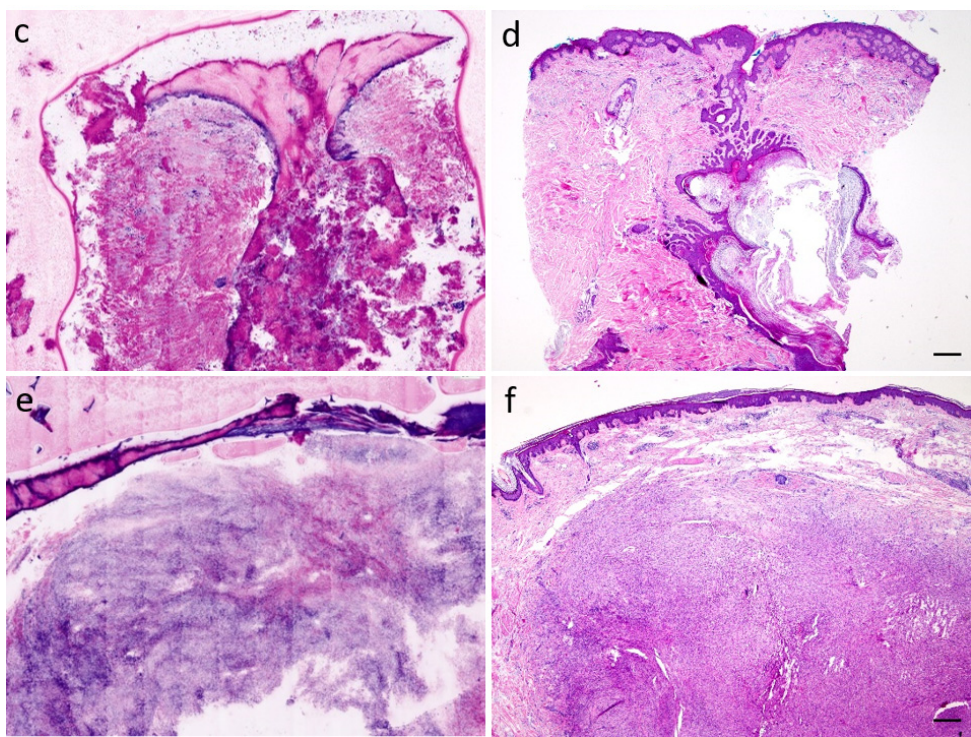
Figure 3. Inflammatory dermatoses, cysts, and other tumors. ( a ) lichen planus verrucosus, CLSM ( b ) lichen planus verrucosus, H&E-stain, scale = 500 µm ( c ) epidermal cyst, CLSM ( d ) epidermal cyst, H&E-stain, scale = 500 µm ( e ) dermatofibroma, CLSM ( f ) dermatofibroma, H&E-stain, scale = 500 µm.